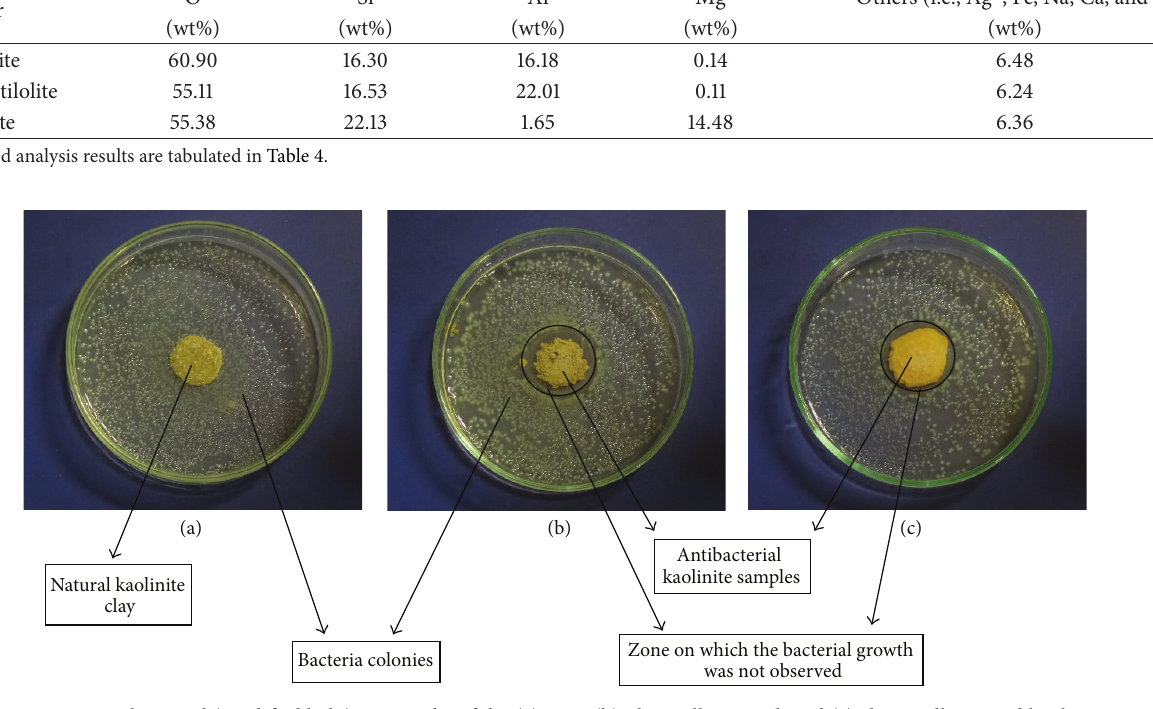
Figure 1: Antibacterial (modified halo) test results of the (a) neat, (b) physically treated, and (c) chemically treated kaolinite.